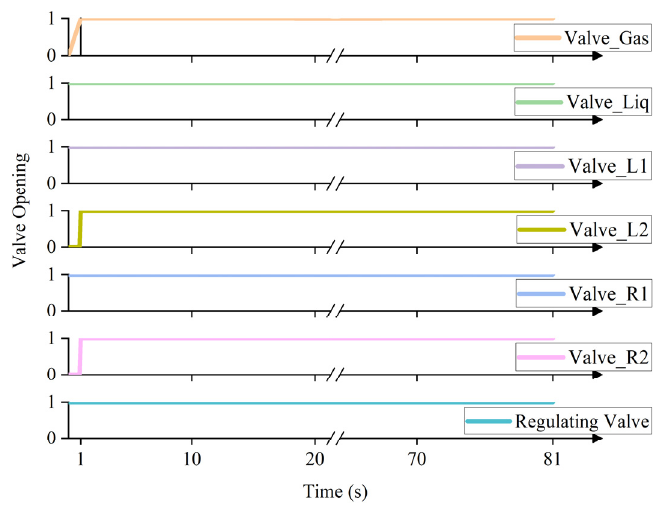
Figure 3. Working sequence of synchronous start (Scheme SYNC).